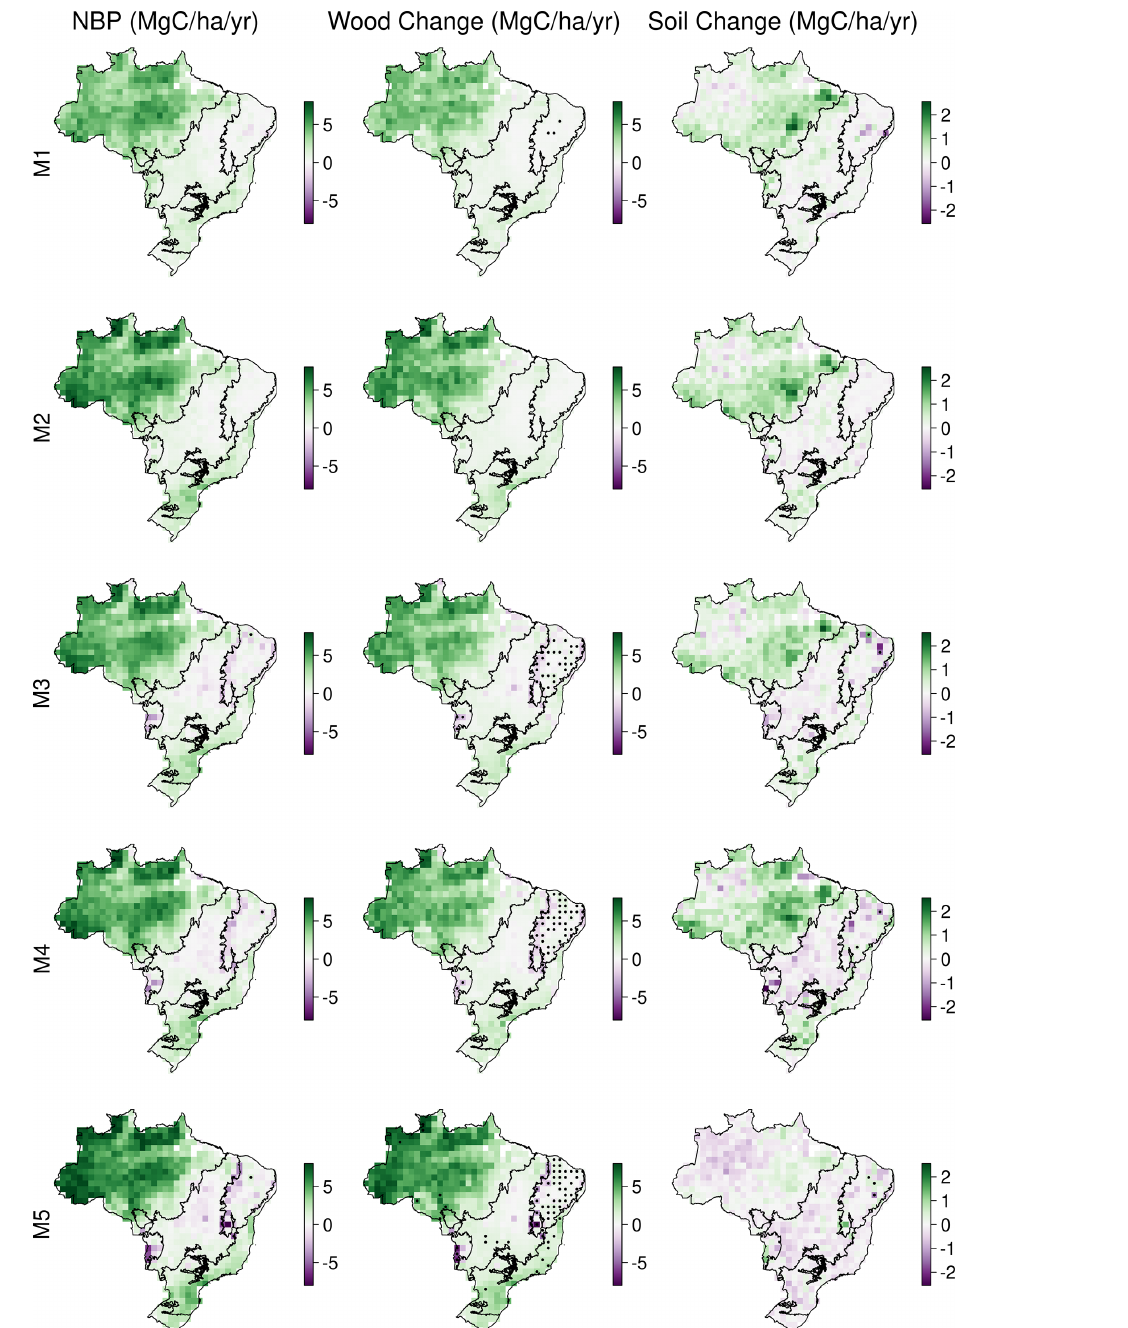
Figure A6. DALEC suite estimates of estimates of net biome productivity (NBP; 2001–2017) (i.e. NBE to provide sign consistency with C stocks), wood and soil carbon stock change. Stippling to indicate > 90% confidence on a given pixel being a net source or sink of carbon during our